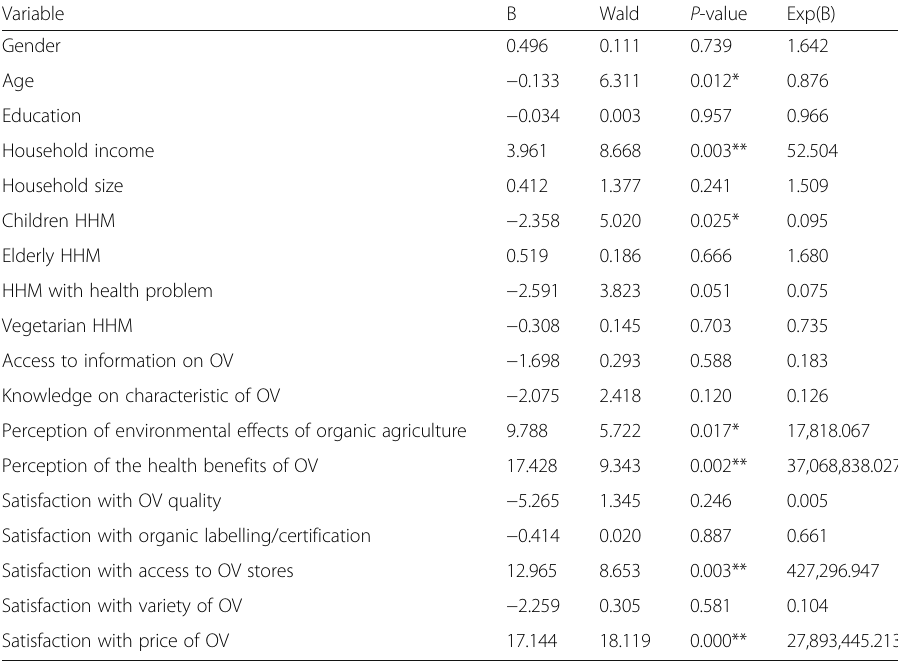
Table 7 Analysis of maximum likelihood estimates of organic vegetable consumption Variable